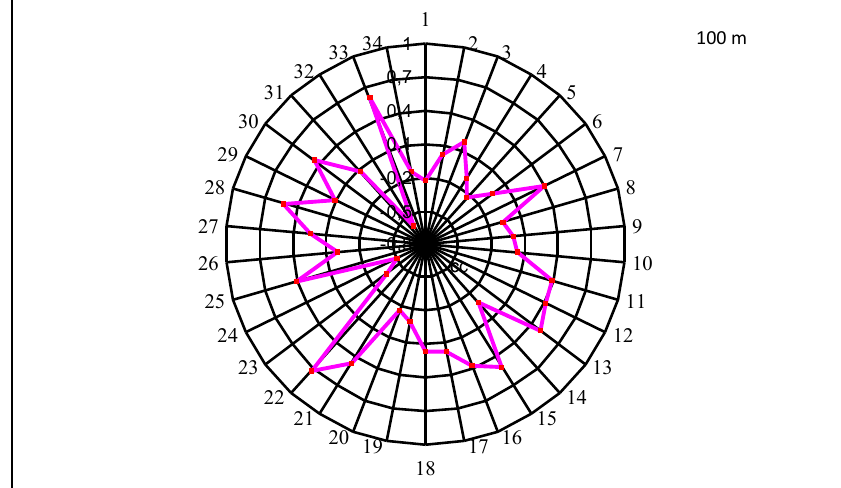
Fig. 3. Correlation of elite sportsmen’s morphological functional indicators with results of 100 meters’